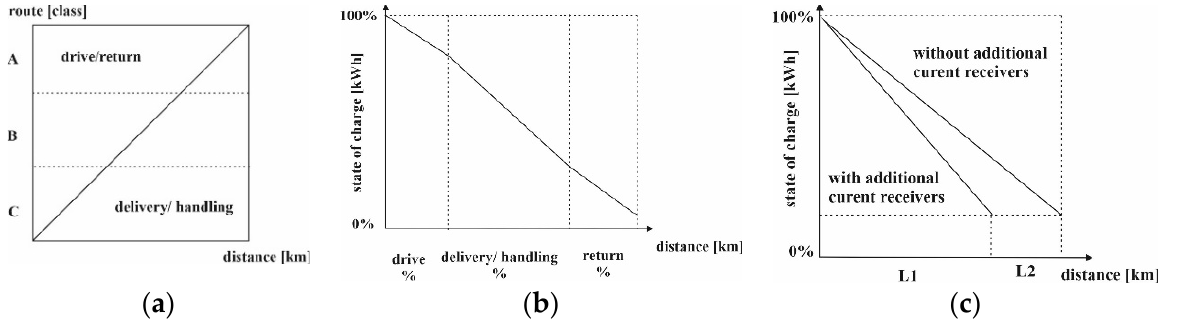
Figure 4. Adopted research assumptions: ( a ) Classes of routes due to the structure of their sections ( b ) Change in the state of charge depending on the nature of the route section ( c ) Range change (L) depending on the reduction of additional energy receivers. Source: Own study.